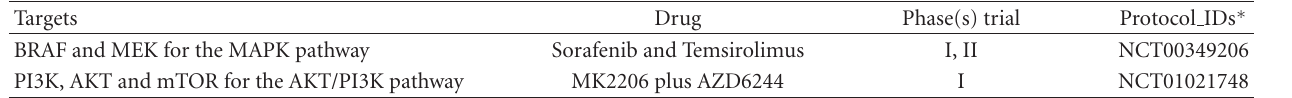
Table 7: Dual Therapeutic